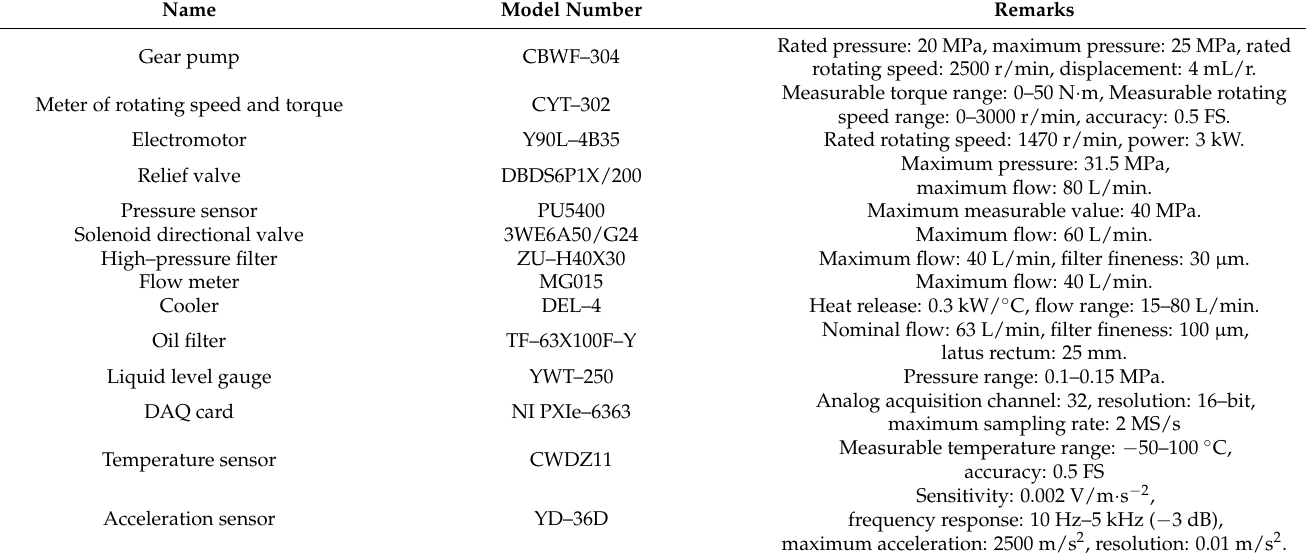
Table 1. Test bench components and their performance